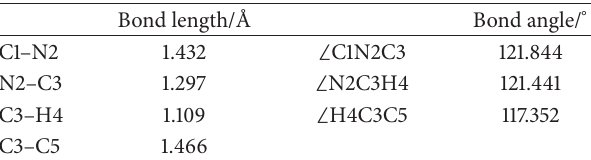
Table 1: Some bond lengths and bond angles of